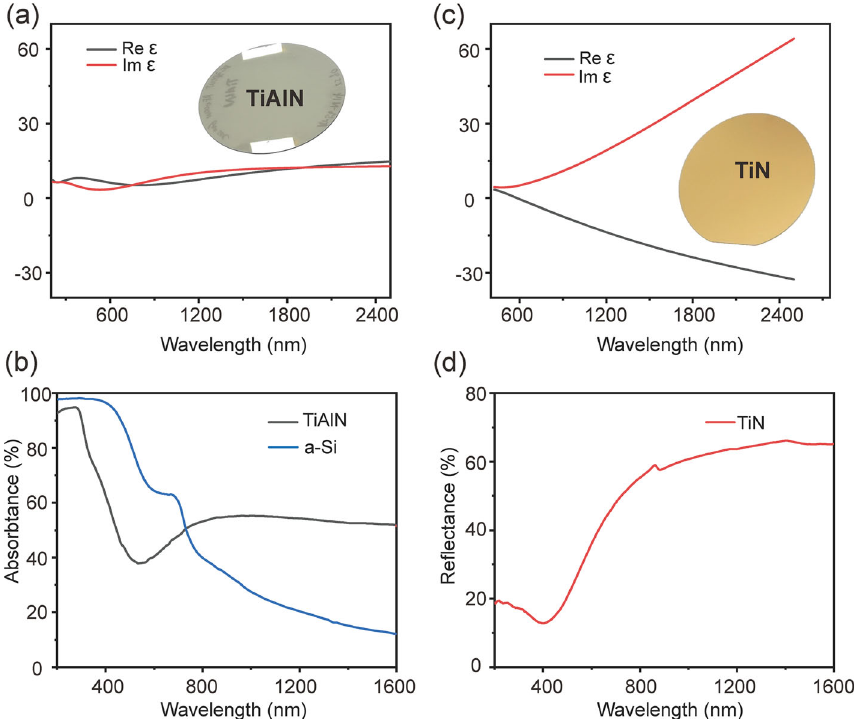
Fig. 1 Measured dielectric constant of TiAlN film ( a ) on a glass substrate, and TiN ( c ) on a silicon wafer. Re (cid:2) : real part of permittivity; Im (cid:2) : imaginary part of permittivity. Insets: photographs of 50-nm-TiAlN and 50-nm-TiN films on a glass and silicon substrate, respectively. b , absorption spectra of 50-nm-thick TiAlN (black curve), and 50-nm-thick a-Si (blue curve). d , Reflectance spectrum of 50-nm-TiN film sputtered on a silicon wafer at 300